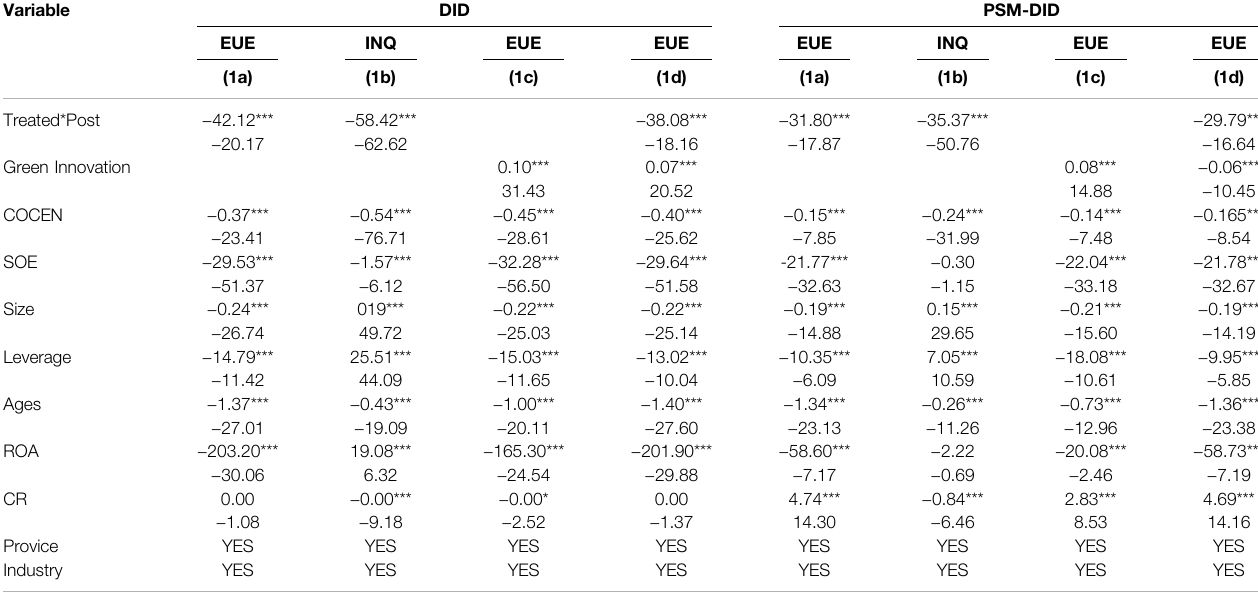
TABLE 13 | OLS robust standard error regression results about excitation by changing the size with Enterprise income. Variable DID